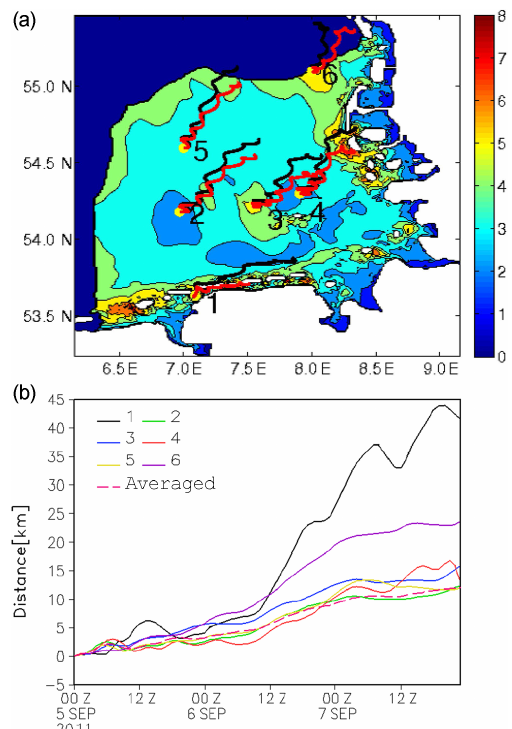
Figure 10. (a) The displacement of Lagrangian particles. Black lines give the results from the model free run; red trajectories visu- alize the results in the data assimilation run. Color coding gives the mean distance in kilometers between position of Lagrangian parti- cles in the analysis and free run for September 2011 after 24h of integration. (b) Distance of drifting particles in the assimilation run and the free